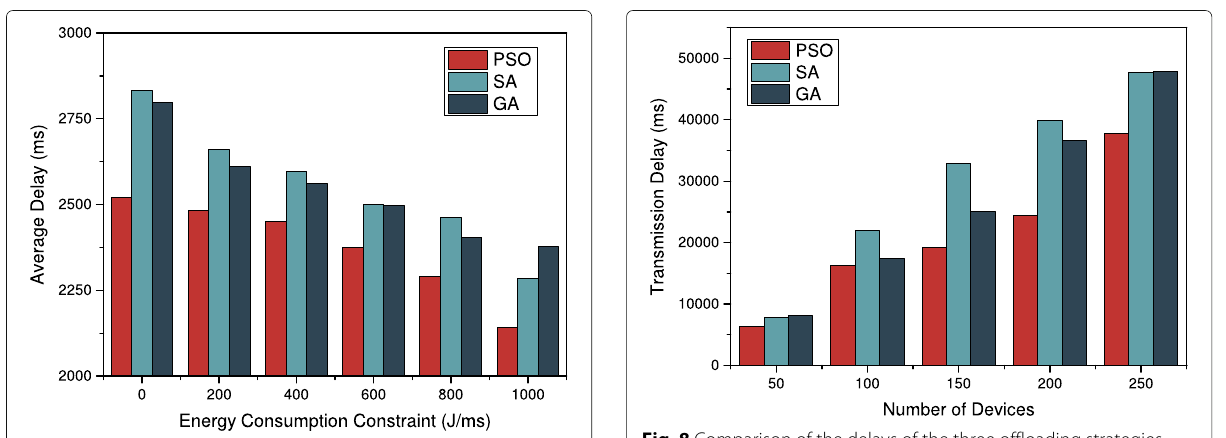
execution delay of the three offloading strategies when